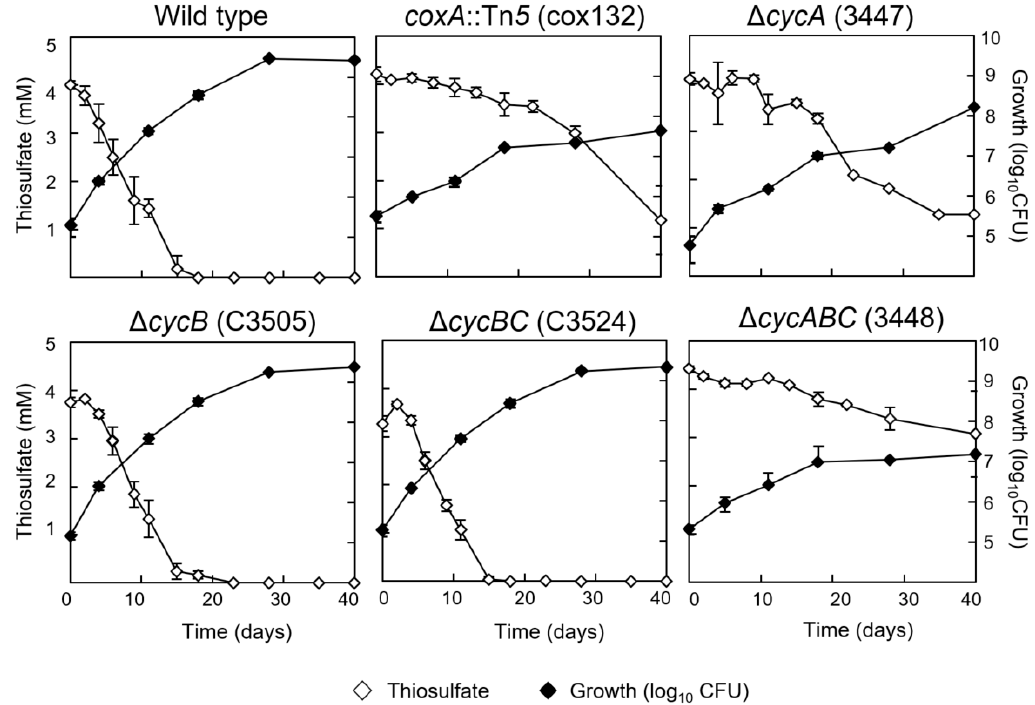
Figure 3. Contribution of cytochromes to chemolithoautotrophic growth of B. diazoefficiens with thiosulfate and CO 2 . The analyzed strains were the wild type and the cytochrome mutants cox132 (lacking subunit I of aa 3 -type cytochrome oxidase), 3447 (lacking cytochrome c 550 ), C3505 (lacking cytochrome c 552 ), C3524 (lacking cytochromes c 552 and c 555 ), and 3448 (lacking all three c -type cytochromes). The starting media contained 4 mM thiosulfate. The panels show thiosulfate consumption and growth measured as colony-forming units (CFU). CFU counts were assessed by taking samples from the cultures and plating out dilutions on agar plates with peptone-salts-yeast extract medium [18]. Shown are the mean values and standard deviation derived from three independent cultures.